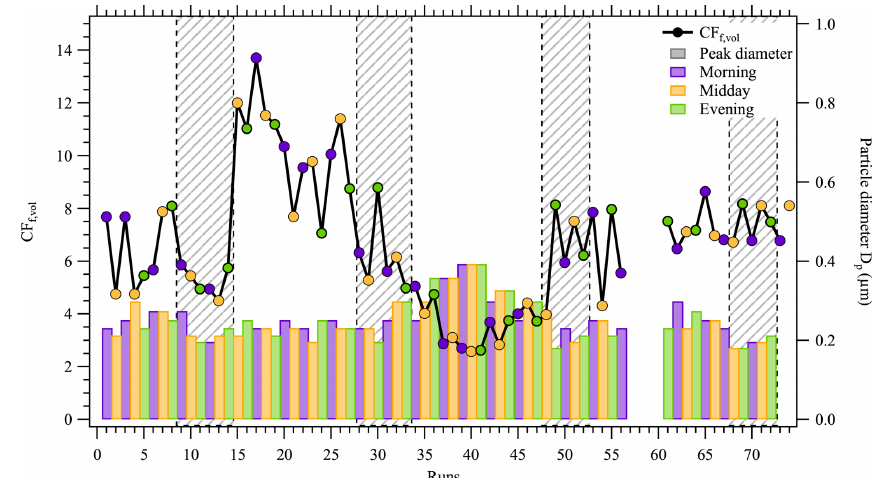
Figure 10. Variability of the peak diameter and CF f , vol color coded according to time of